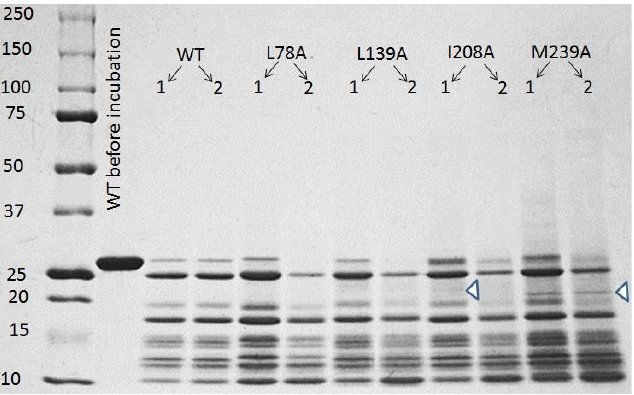
Figure 7. SDS-PAGE electrophoregrams of carbonic anhydrase solutions, wild-type and L78A, L139A, I208A, M239A mutant forms, incubated at pH 2.7, 57 °C for one (1) and two (2) days. Left column: molecular weight markers. The second column from the left: wild-type carbonic anhydrase before the incubation. The proteins were stained with Coomassie Blue